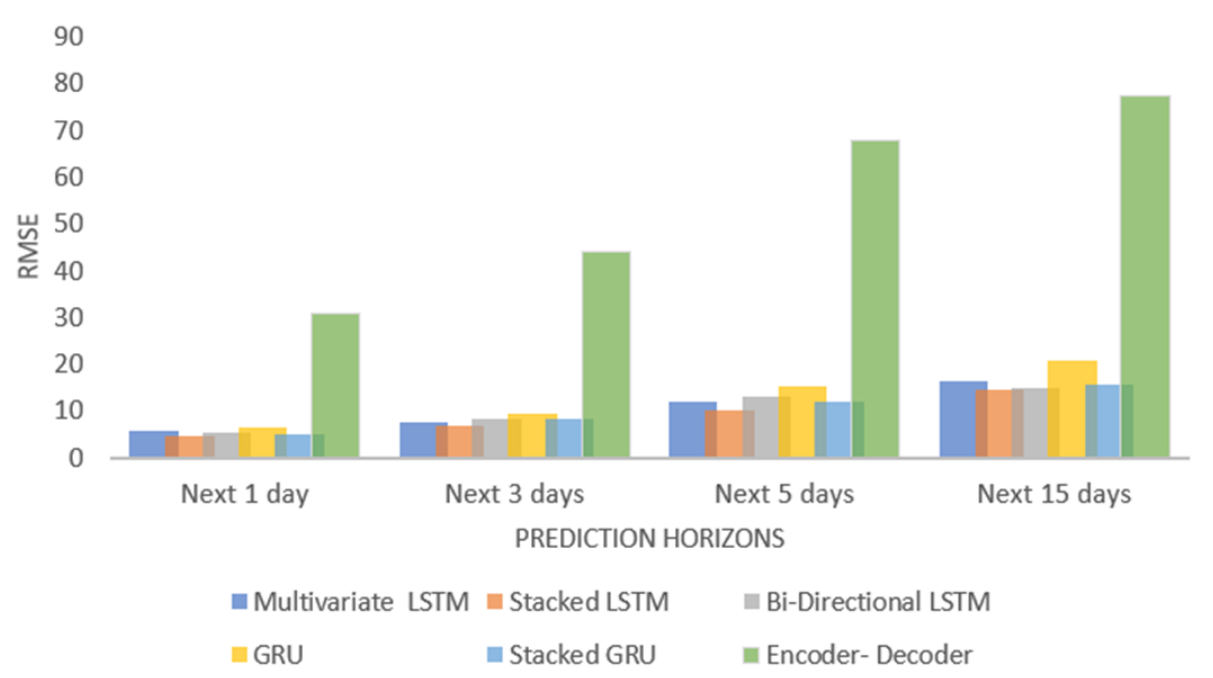
Figure 17. Comparision between several multivariate models.